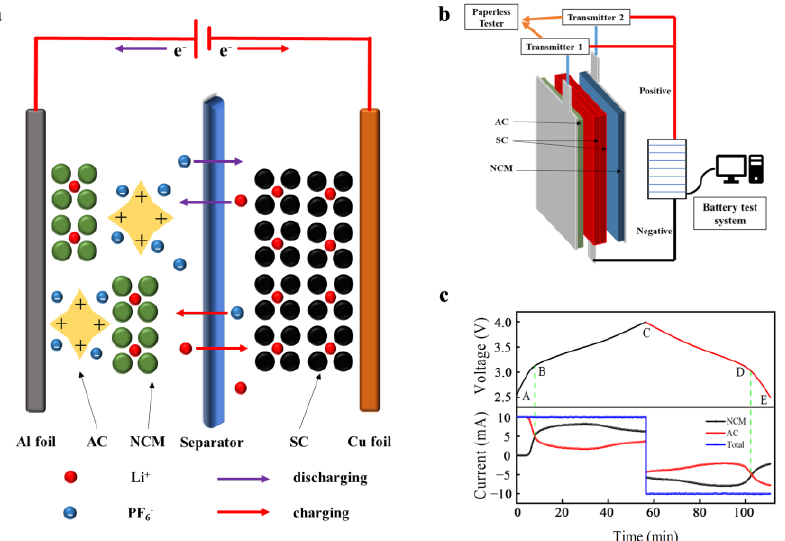
Figure 2. ( a ) Schematic diagram of the structure and working principle of a typical LIBC; ( b ) Measurement configuration of segmented cathode structure for monitoring current contribution; ( c ) Voltage profile and current contribution upon galvanostatic charge and discharge processes [39].